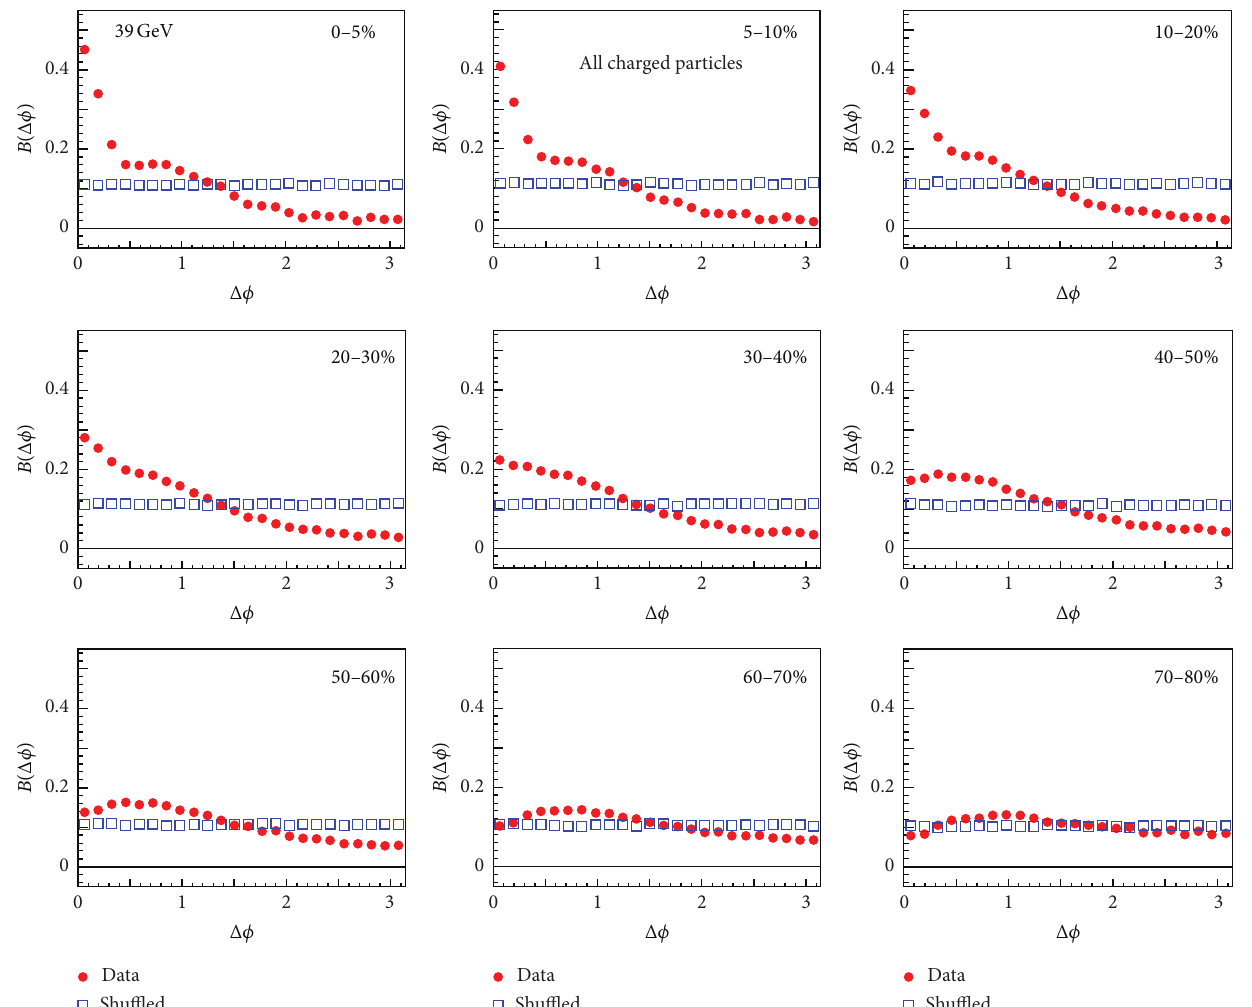
= 39 GeV. The graph is taken NN